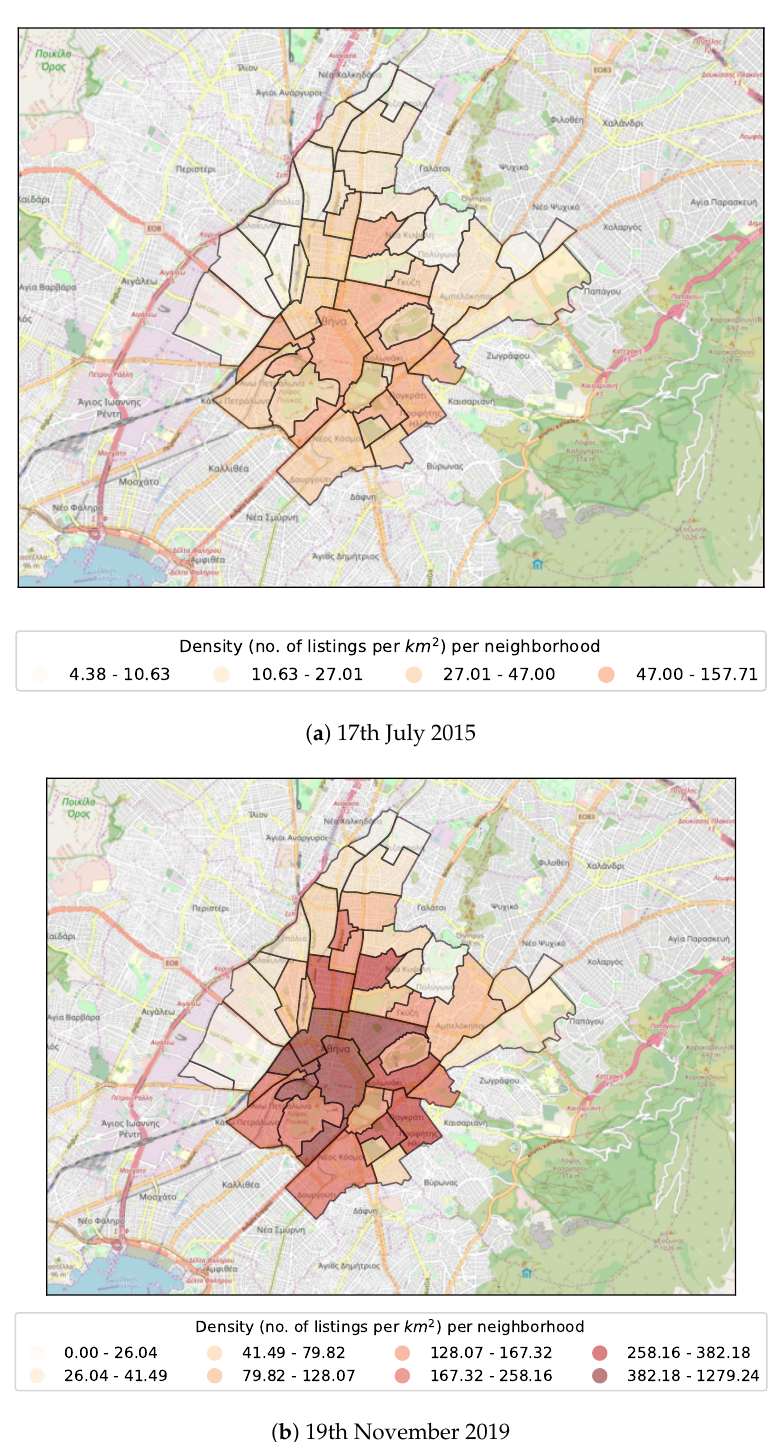
Figure 1. Change of density of Airbnb listings in Athens neighborhoods between 2015 and 2019 (color